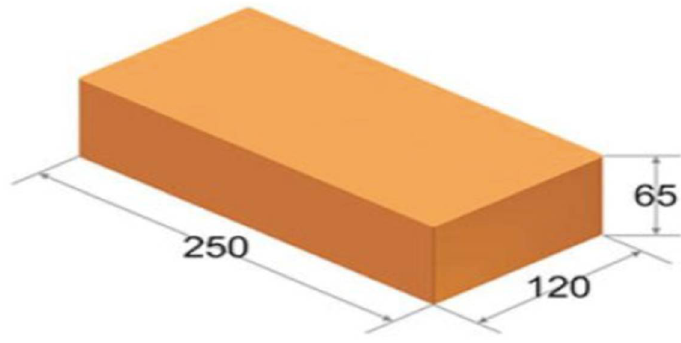
Figure 1. View of solid brick samples subjected to measurements.